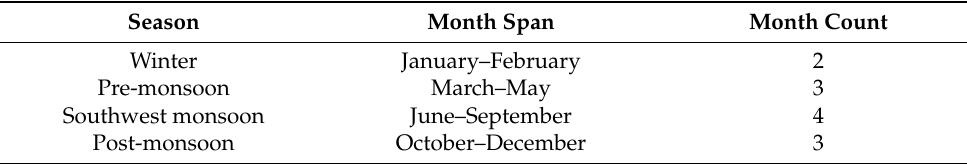
Table 1. Months of the year in different seasons experienced in